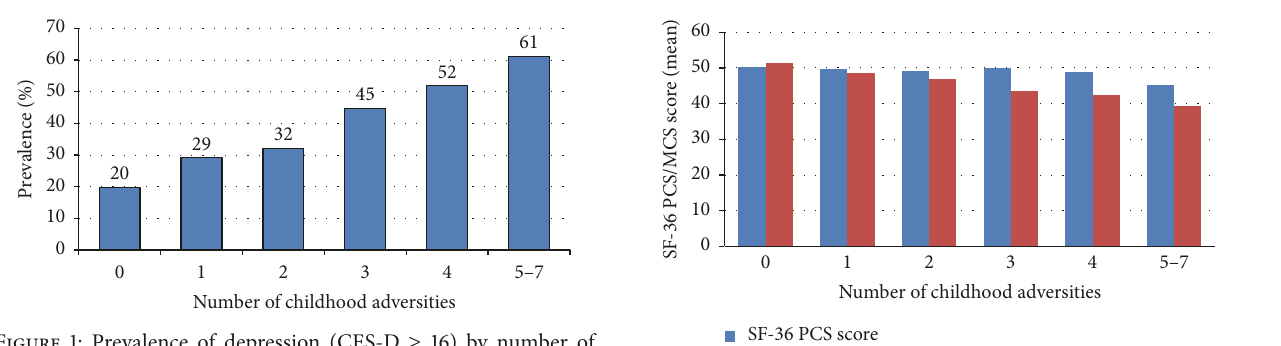
Figure 1: Prevalence of depression (CES-D ≥ 16) by number of childhood adversities. Note . Trend was significant (Chi-square trend test; 𝜒 2 = 99.0; 𝑝 < 0.001 ). Figure 2: SF-36 PCSand SF-36 MCSscoresby number ofchildhood adversities. Note . There was a significant linear trend for SF-36 MCS score (ANOVA trend test; 𝐹 = 77.2.9 ; 𝑝 < 0.001 ), but not for SF-36 PCS score (ANOVA trend test; 𝐹 = 2.2 ; 𝑝 = 0.134